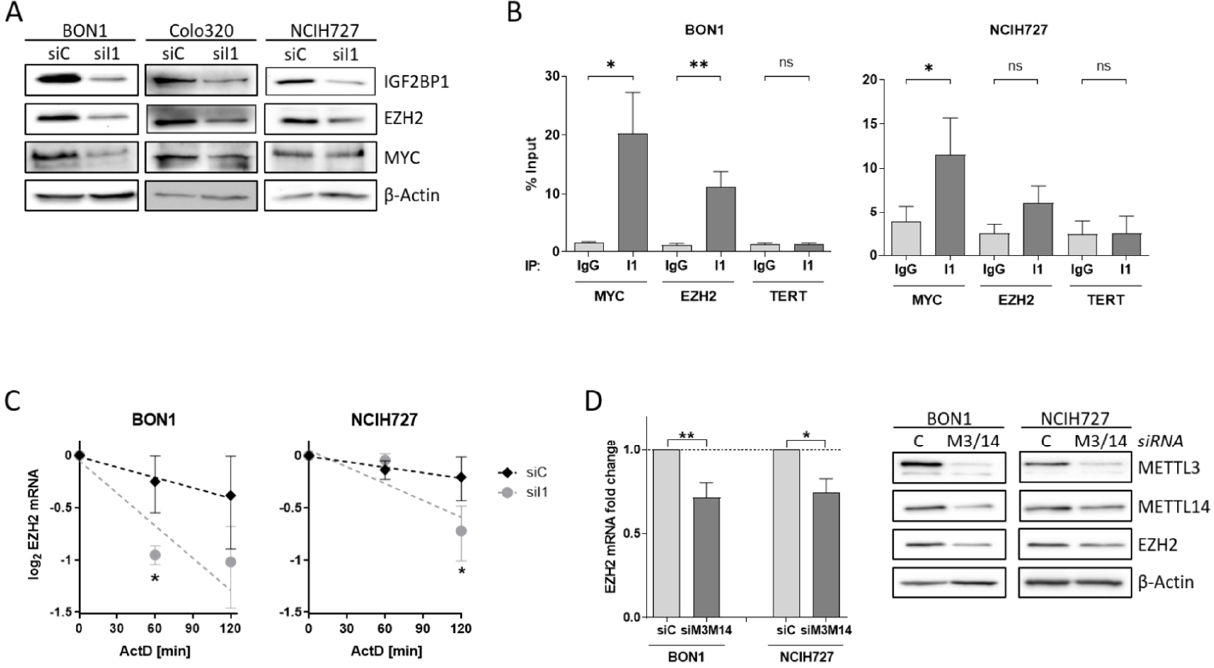
Figure 4. IGF2BP1 regulates EZH2 mRNA stability. ( A ) Representative Western blots of indicated proteins upon knock-down of IGF2BP1 (siI1) in NEN cells. Actin served as loading control. ( B ) RNA-Immunoprecipitation (RIP) analysis by qRT-PCR after pulldown of IGF2BP1 protein. Binding of MYC and EZH2 mRNA to IGF2BP1 was compared to IgG isotype control. TERT mRNA served